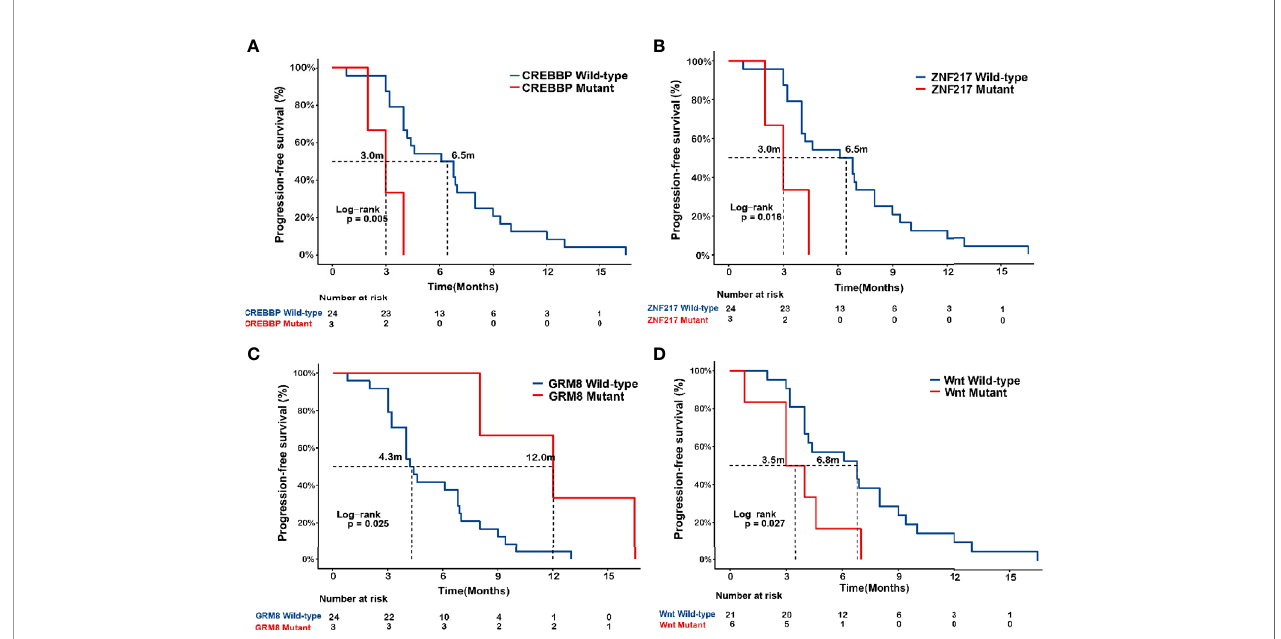
FIGURE 4 | Associations of CREBBP , ZNF217 , GRM8 , and Wnt pathway mutation with EGFR-TKI outcome in EGFR -mutant squamous cell carcinoma (SCC). Kaplan-Meier curves of progression-free survival (PFS) in EGFR -mutated lung squamous cell carcinoma (SCC) in terms of mutational status of CREBBP (A) , ZNF217 (B) , GRM8 (C) , and Wnt pathway (D) .